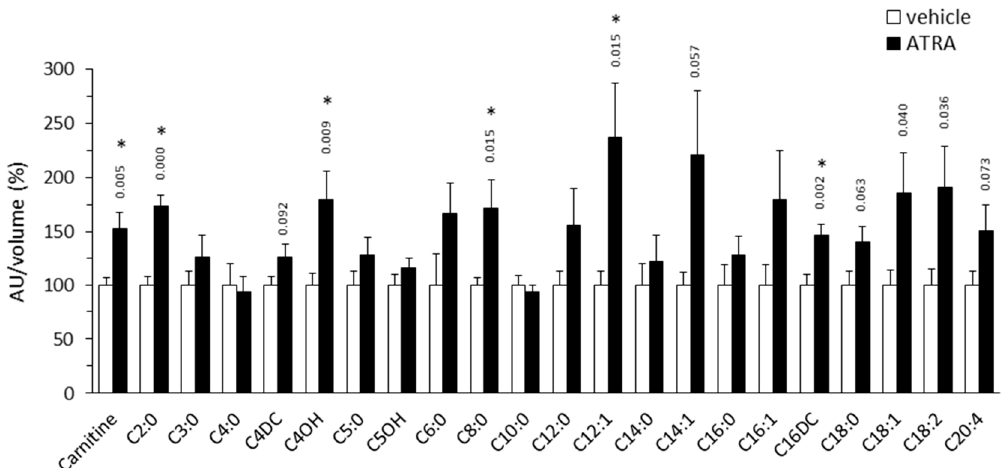
Figure 1. Relative plasma levels of carnitine and the indicated acylcarnitines species in NMRI mice treated with all-trans retinoic acid (ATRA; 50 mg/kg body weight, subcutaneous injection) or the vehicle (olive oil) during 4 days. Metabolite peak area (as arbitrary units, AU) was normalized by the volume of plasma used in LC-MS/MS. Data are expressed as percentage with respect to the normalized value in the control group, which was set to 100%, and are the mean ± SEM of 11 animals per group. * Indicates significant difference between the ATRA and the control group after Benjamini– Hochberg correction (observed p values in two-tailed Student’s t test are indicated when p < 0.1).